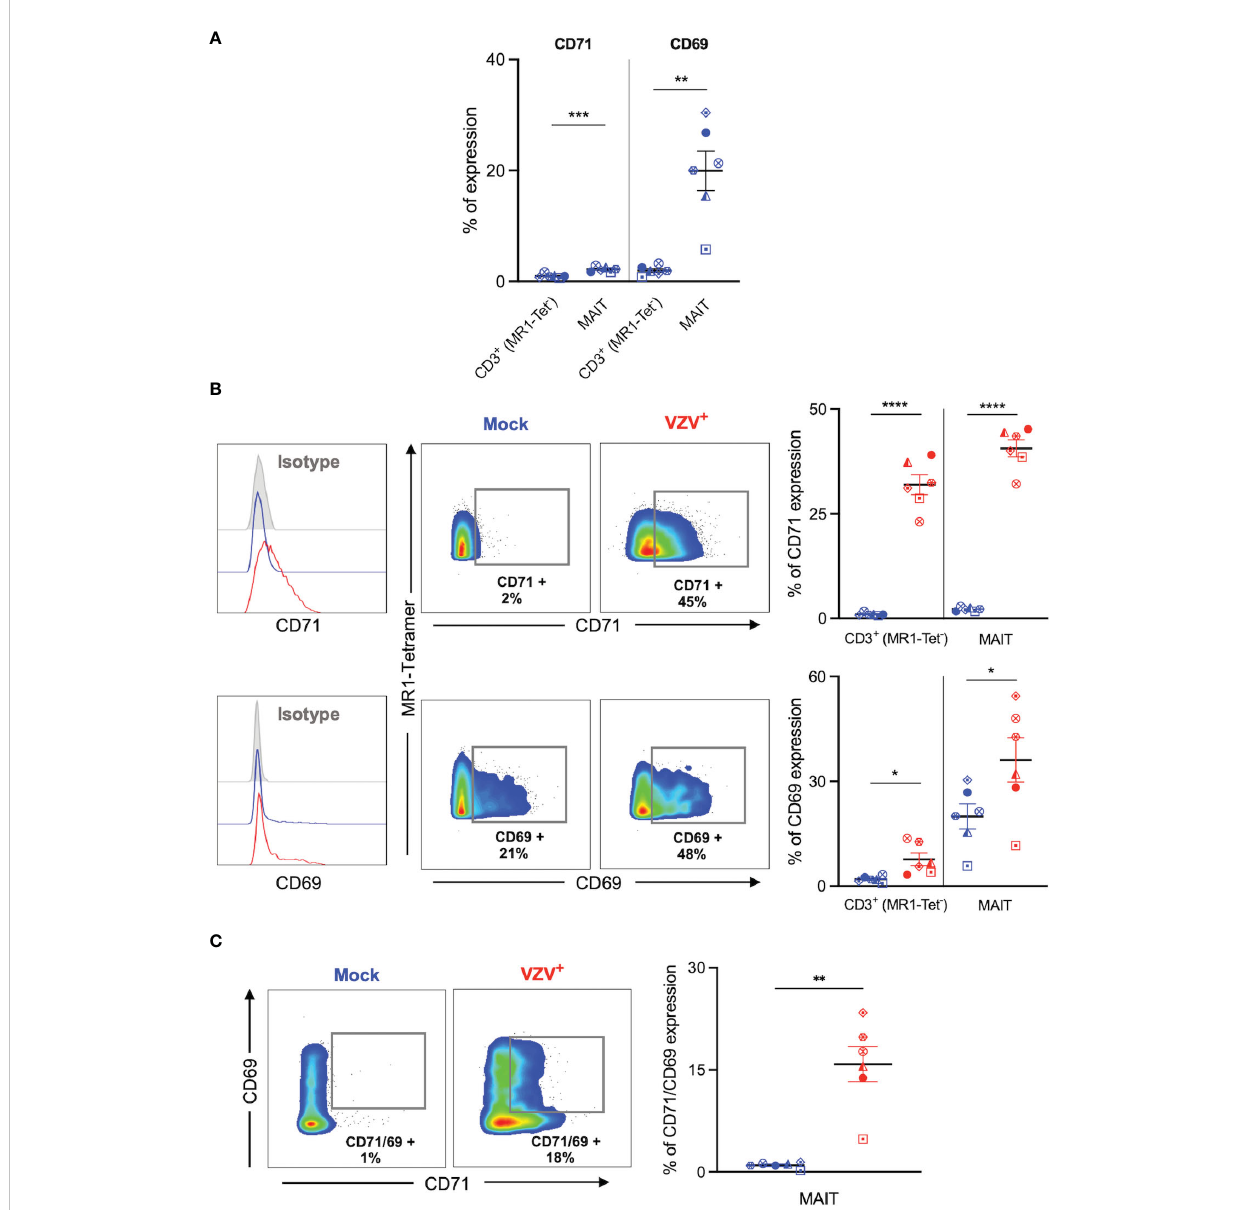
FIGURE 3 VZV infection of MAIT cells is associated with expression of early activation and proliferation markers. Human PBMCs were inoculated with mock or VZV-S infected ARPE-19 epithelial cells for 2 days and then analyzed for infection (gE:gI), proliferation (CD71), and early activation (CD69) markers by fl ow cytometry. (A) Graph shows comparative frequency of surface CD71 and CD69 expression in mock inoculated non-MAIT (ie MR1-Tet - ) CD3 + T cells and MAIT cell populations, with symbols representing individual donors (n=6). Statistical analysis was performed via two tailed paired t test. **p<0.001, ***p<0.001. (B) Representative histograms show expression of CD71 and CD69 by MAIT cells for Mock (blue) and VZV infected (VZV + ) (red) populations corresponding to their respective isotype controls ( fi lled grey). Flow cytometry plots show surface expression of CD71 and CD69 on MAIT cells for Mock (blue) and VZV infected (VZV + ) (red) populations. Graphs show frequency of CD71 and CD69 in non-MAIT (ie MR1-Tet - ) CD3 + and MAIT cell subpopulations, with symbols representing individual donors, and mean and SEM indicated by the bars. Statistical analysis of CD71 and CD69 expression between Mock and VZV + infected non-MAIT CD3 + cells and MAIT cells was performed via two tailed paired t test (n=6). *p<0.05, ****p<0.0001. (C) Flow cytometry plots show CD69 vs CD71 double expression on Mock (blue) and VZV infected (VZV + ) (red) populations. Graph shows frequency of CD69/CD71 double expressing MAIT cells, with symbols representing individual donors, and mean and SEM indicated by the bars. Statistical analysis of CD71 and CD69 expression between Mock and VZV + infected non-MAIT CD3 + cells and MAIT cells was performed via two tailed paired t test (n=6). *p<0.05,